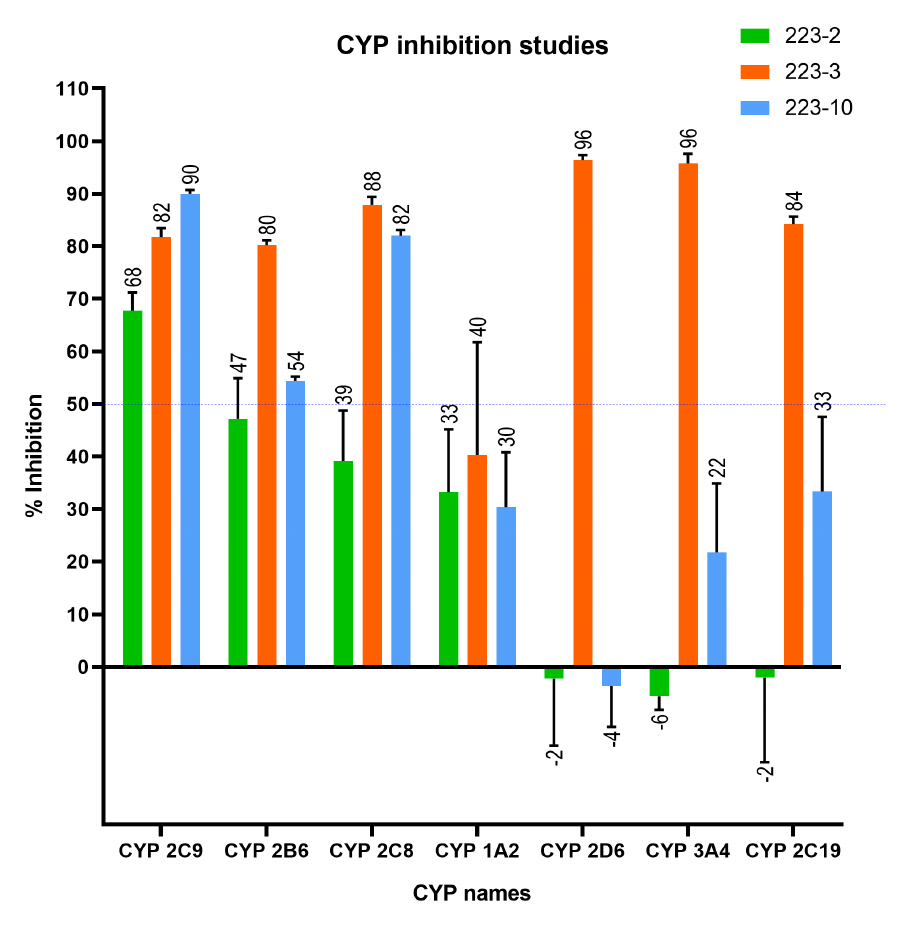
Figure 6. Inhibition assay results of TbB ligands by human CYP involving most common isoforms and their respective probe substrates at a single concentration of 10 µ M (n = 3). The TbB ligand 223-3 was observed to have an above 50% inhibitory effect on all the CYP isoforms except CYP1A2. The TbB ligands 223-2, 223-3, and 223-10 exhibited an inhibitor effect of above 50% on CYP2C9. Based on the CYP inhibition assay, inhibiting ligands can potentially be ranked as 223-3 > 223-10 > 223-2. Therefore, 223-2 is the less prominent